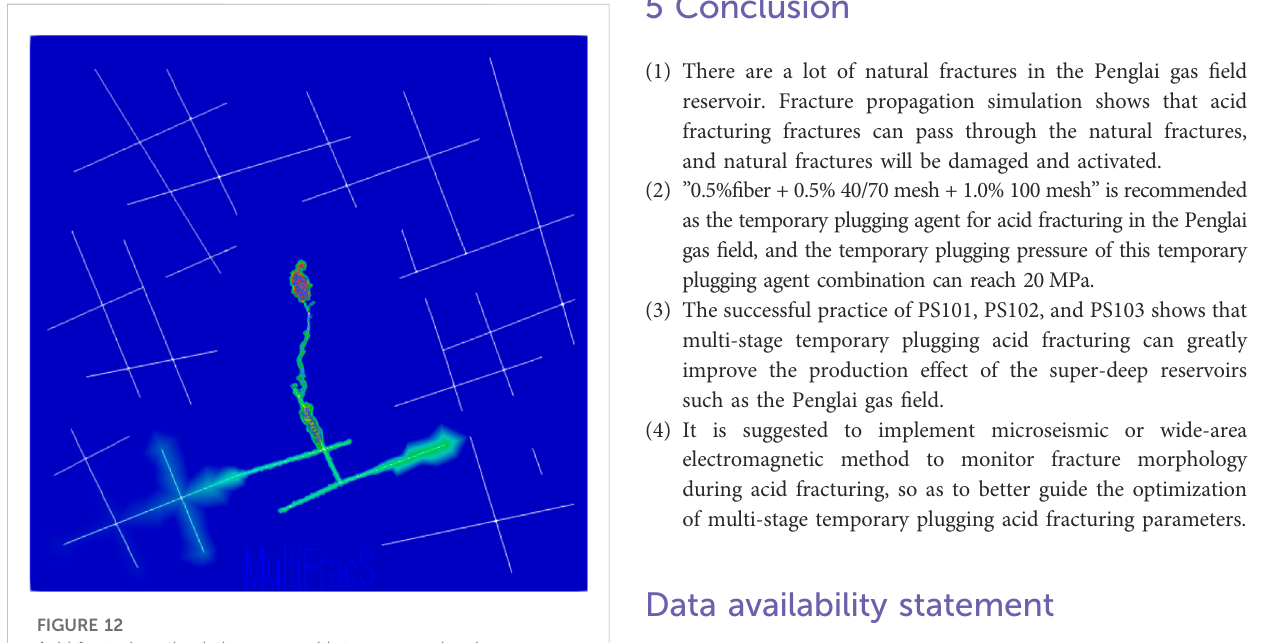
FIGURE 12 Acid fracturing stimulation range with temporary plugging pressure 20